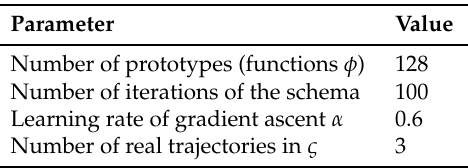
Figure 4. Sequence of images of the learned trajectory using a standard RL process with Sarsa( λ ) algorithm. Sarsa is a standard RL algorithm. The thick (red) line shows the learned trajectory. Table 3. IRL experiment setup.